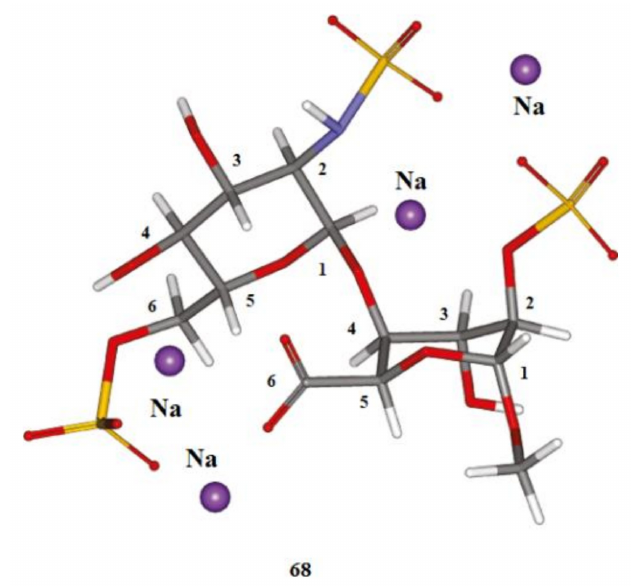
Figure 33. The structure of heparin disaccharide—methyl O -(2-deoxy-2-sulfamino-6- O -sulfo- α - D-glucopyranosyl)-(1 → 4)-2- O -sulfo- α -L-idopyranoside uronate tetrasodium salt. Element colors: hydrogen—light gray, carbon—gray, nitrogen—violet, oxygen—red, sulphur—yellow. Repro- duced with minor editing privilege from Hricov í ni [144] with the permission of the American Chemical